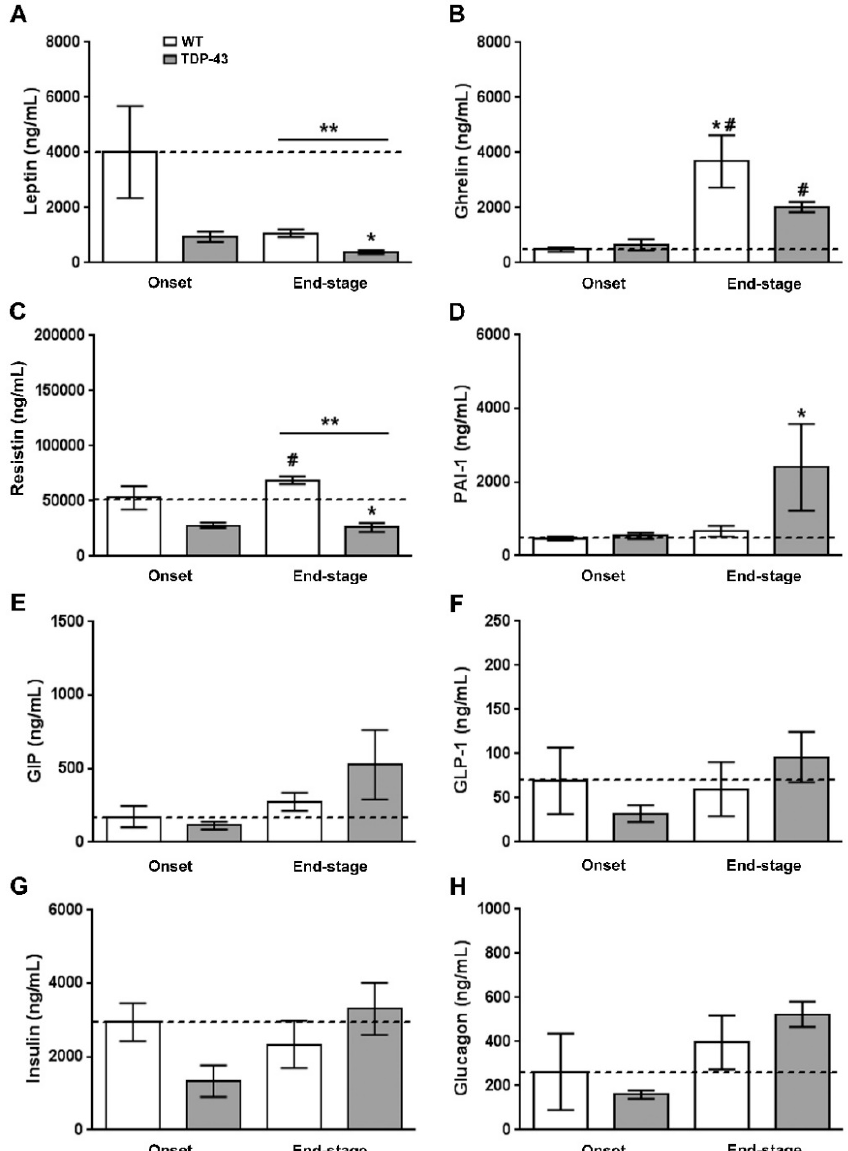
Figure 2. Adipocytokines and metabolic biomarkers levels in WT controls and TDP-43A315T mice. Total plasma leptin ( A ), ghrelin ( B ) and the adipokine resistin ( C ), and ( D – H ) metabolic biomarkers of insulin resistance (PAI-1, GIP, GLP-1, insulin, and glucagon) were measured over the time course of the disease in TDP-43 A315T mice compared to age-matched WT littermates using Luminex ® 200 TM technology. Values are expressed as the mean ± SEM for the different groups (n = 5 per genotype/stage of disease). Kruskal–Wallis test was performed followed by Dunnett’s post hoc test to compare all groups with WT onset stage, while Bonferroni post hoc test was used for multiple comparisons between all groups, where * p < 0.05 vs. WT onset stage; # p < 0.05 vs. TDP-43 A315T onset; ** p < 0.05 vs. WT end-staged. Abbreviations: PAI-1, plasminogen activator inhibitor type 1; GIP, gastric inhibitory peptide; GLP-1, glucagon like peptide 1.